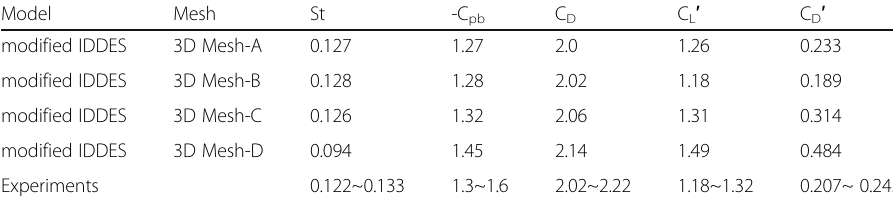
Table 4 Results obtained by 3D simulations with modified IDDES model on Mesh-B